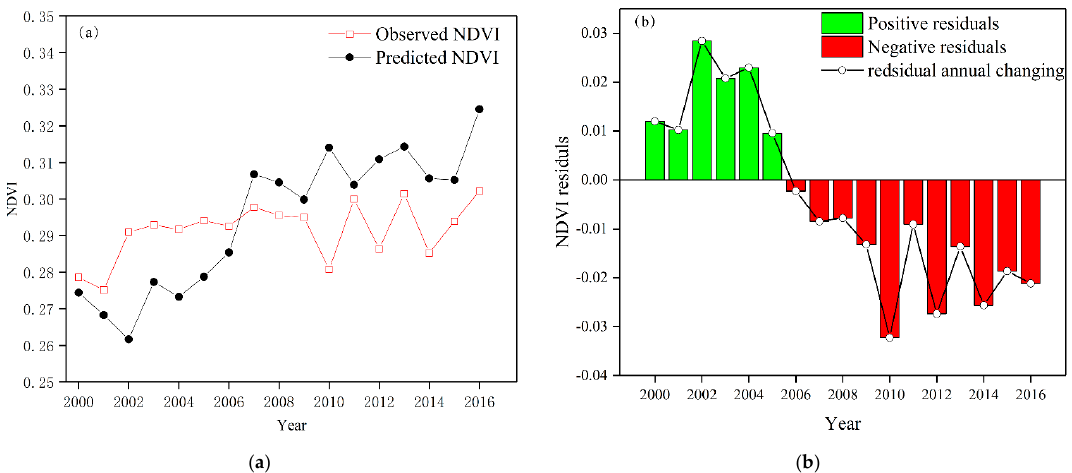
Figure 8. Residual analysis of the annual observed and predicted NDVI ( a ) and the temporal changing of NDVI residuals ( b ).